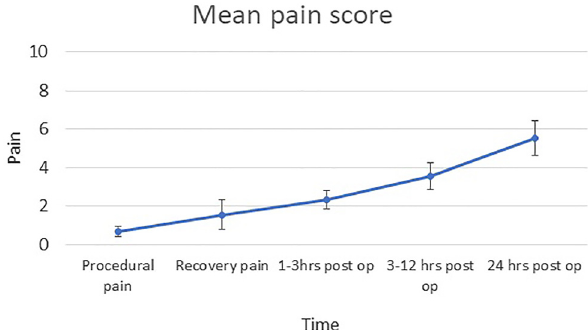
Figure 3: Functional pain scoring following discharge from hospital